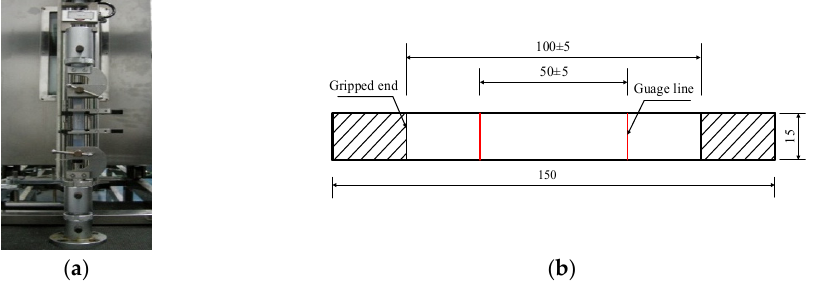
Figure 2. The experimental apparatus (NSS, Shenzhen, Guangdong, China) and ETFE membrane specimen. ( a ) Experimental apparatus. ( b ) Rectangular specimen (mm).